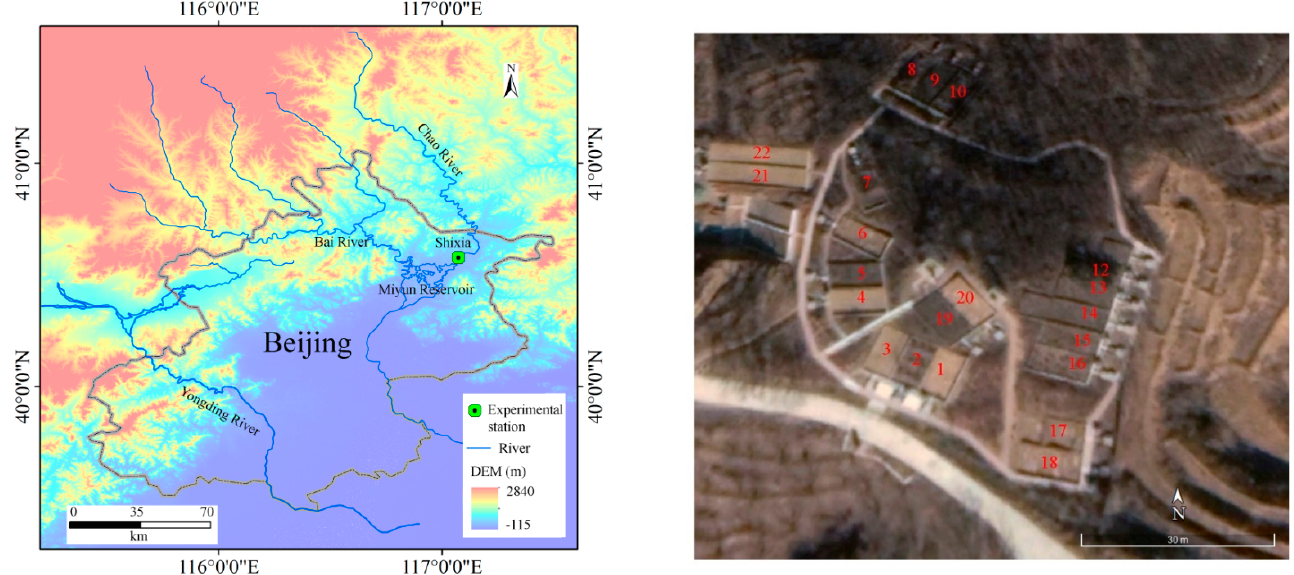
Figure 1. Location of the 22 runoff plots. Note: the lower figure was made from a Google image. In the study region, the main vegetation is Robinia pseudoacacia , Platycladus orientalis , and economic forest, and the main crops are corn and wheat. Around 60.9% of the sandy loam soil contains particles larger than 0.05 mm in diameter, 18.22% contains